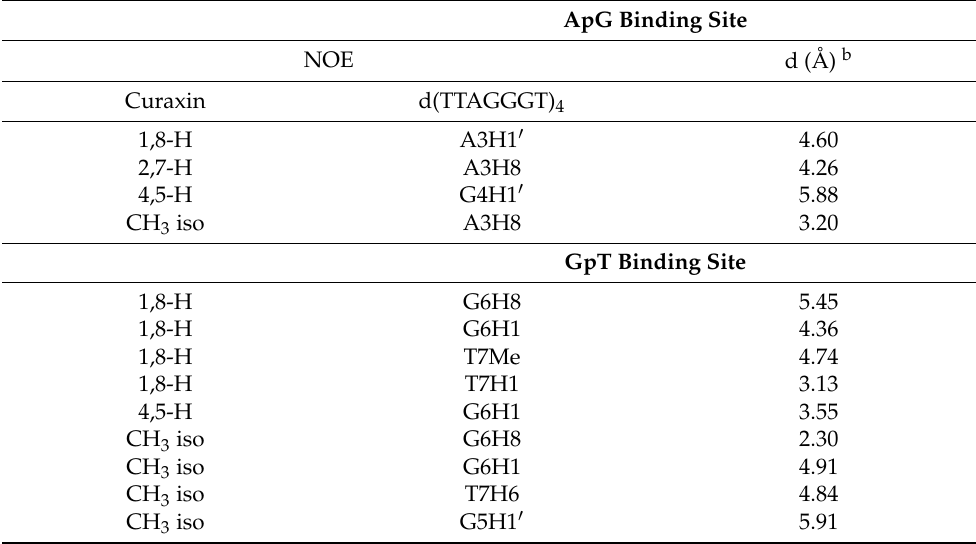
Figure 3. Selected region of the 2D NOESY spectrum of d(TTAGGGT) 4 /curaxin complex. ( a ) G6 imino proton displays intermolecular NOEs between CH 3 T7 and CH 3 (isopropyl) of curaxin; ( b ) A3, G6 and T7 aromatic protons and methyl groups of T2 and T7 of T2AG3T display intermolecular NOEs with CH 3 (isopropyl) and aromatic protons of curaxin; ( c ) schematic representation of d(TTAGGGT) 4 /curaxin (in red) complex.